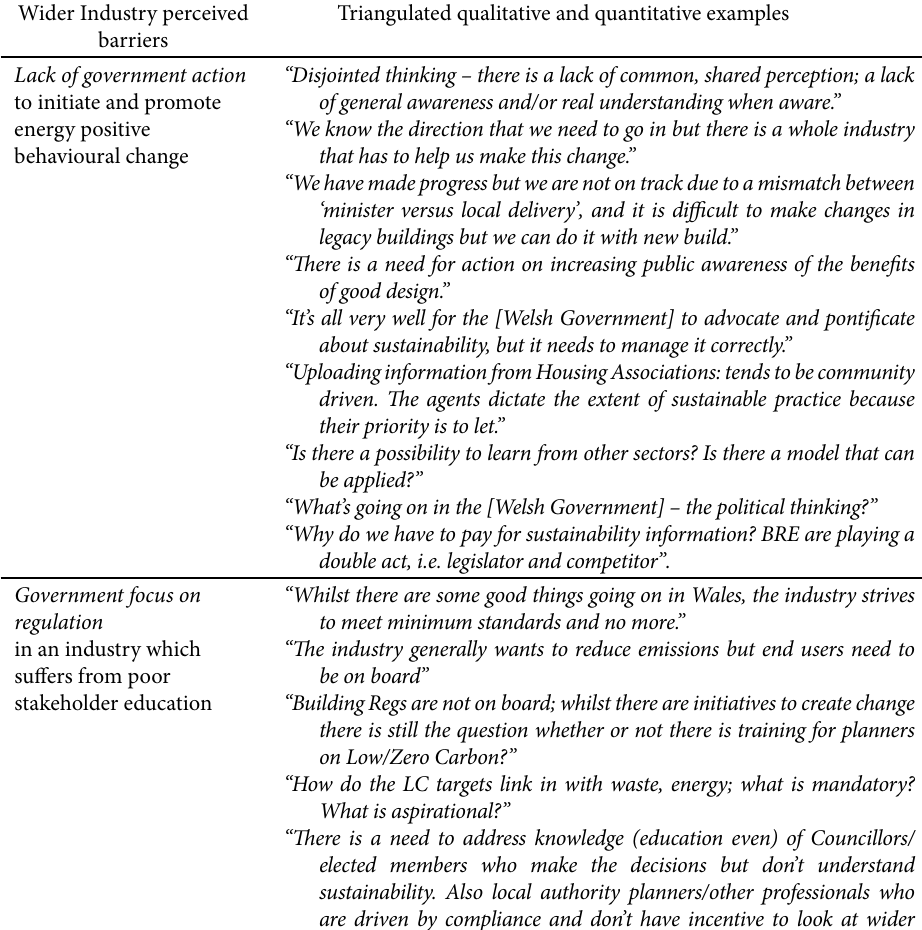
Table 4. Wider industry perceived barriers to engagement with sustainable construction Wider Industry